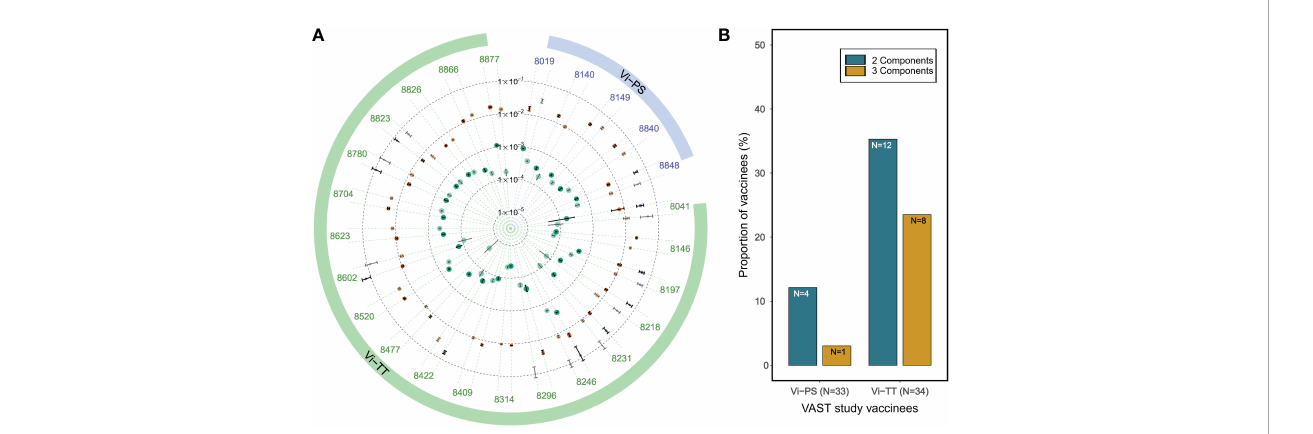
FIGURE 6 PAART analysis differentiates the avidity heterogeneity between Typhoid vaccine arms. (A) A radial plot of different k d values dissected from the dissociation phases (in duplicate) of serum IgG antibodies of VAST clinical trial participants that received either a Vi-PS or a Vi-TT vaccine are shown. Duplicate data shown are the best two replicates of the triplicate time-courses measured. (B) The proportion of vaccinees with ≥ 5% of 2 and 3 antibody avidity components resolved by PAART analysis are shown for Vi-PS and Vi-TT groups of VAST clinical trial participants. In panel A, the error bars associated with symbols indicate the standard error in the estimate of k d values.